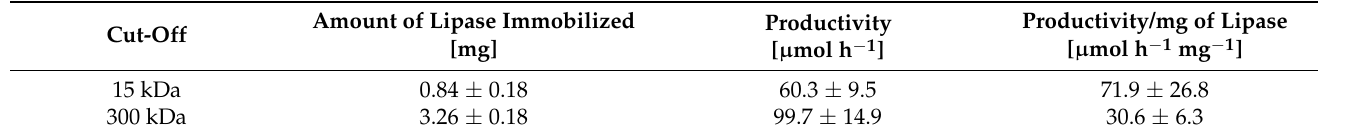
Figure 10. Conversion rate as a function of reaction time with CALB lipase immobilized in a 15 and 300 kDa cut-off membrane. Table 4. Results of determination of lipase activity in cut-off 15 and 300 kDa enzyme membranes for the cross-flow